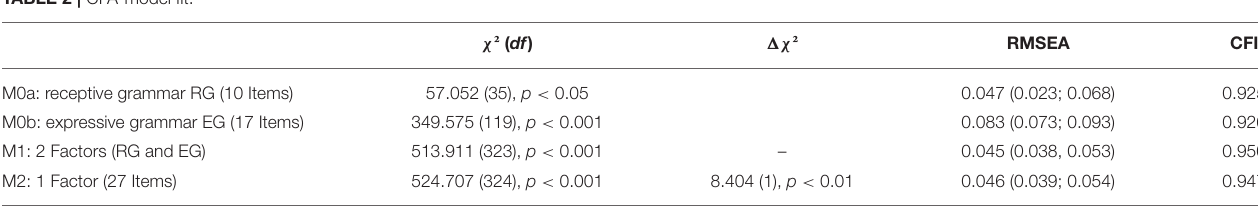
TABLE 2 | CFA-model